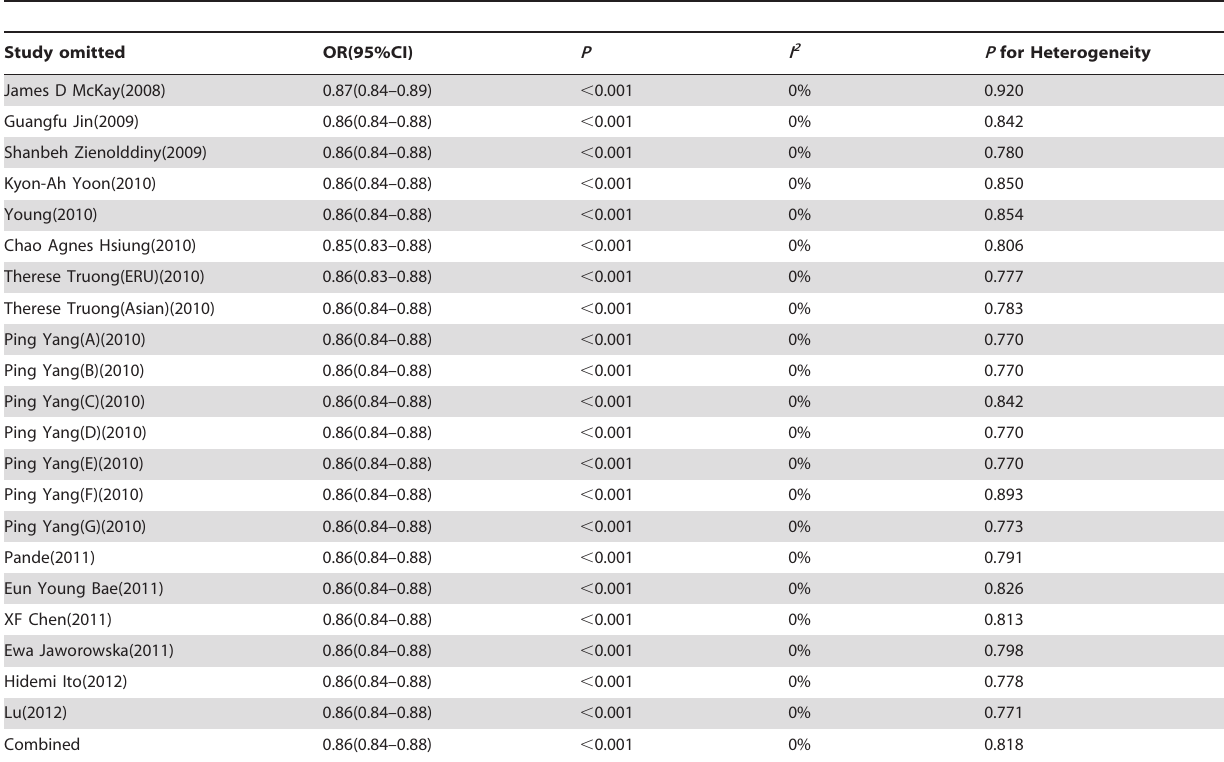
Table 6. Sensitivity analysis of the allelic